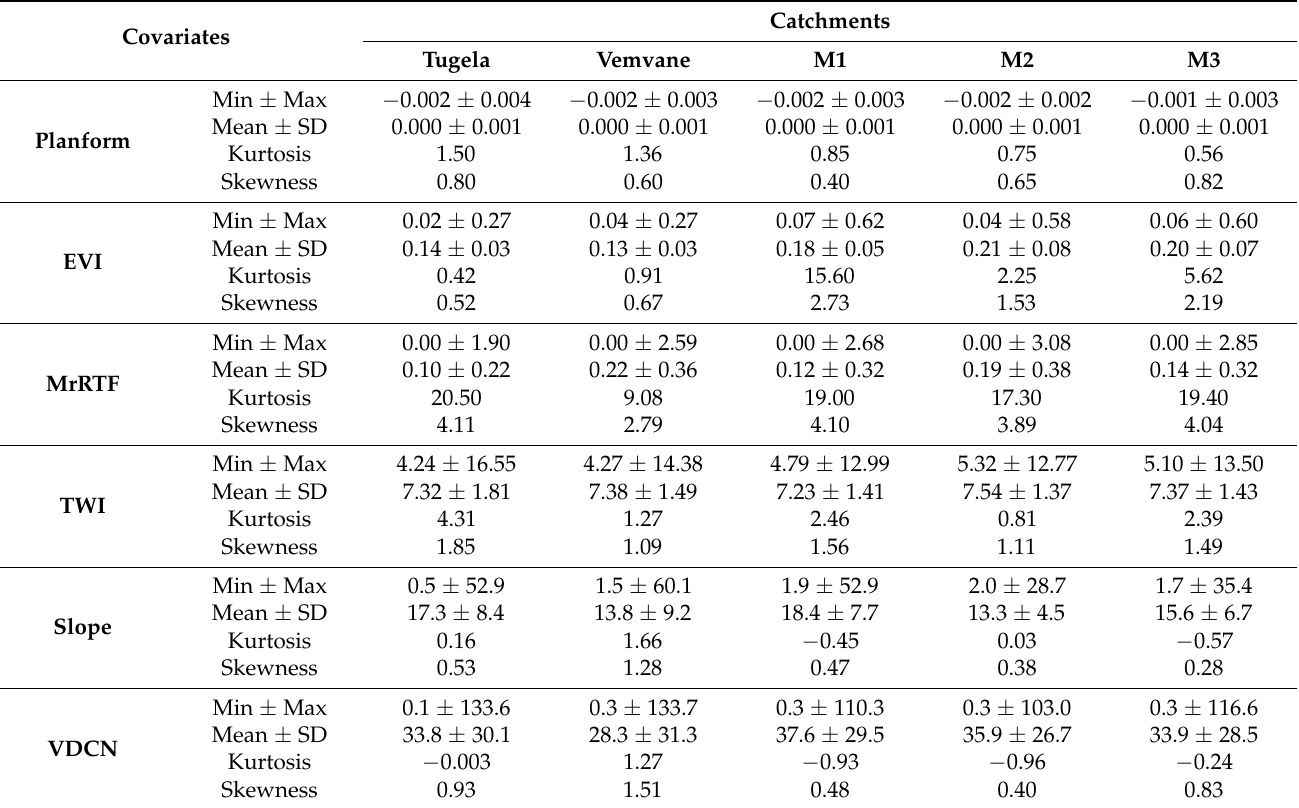
Table 4. Summary of all the catchments’ covariate values in terms of their minimum, maximum, mean, standard deviation, kurtosis, and